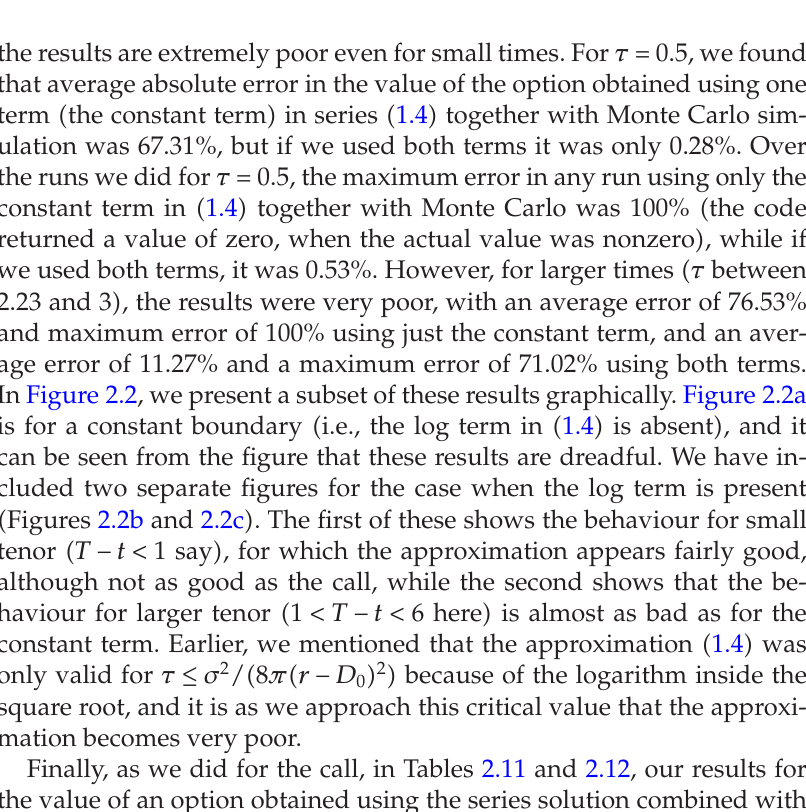
= 0 . 9, E = 1 . 2, r = 0 . 5, 0